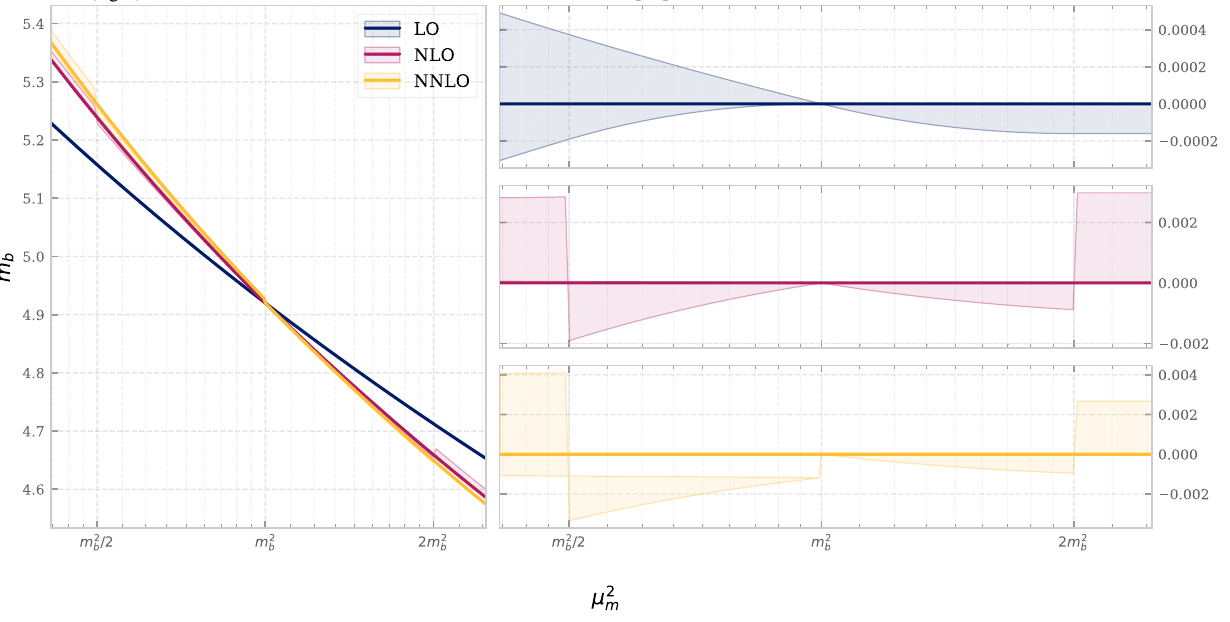
(and slightly beyond) at LO, NLO, and NNLO. The border condition for the running has been chosen at m b ( m b ) = 4 . 92 GeV, as it is clear from the plot, since it is the intersection point of all the curves